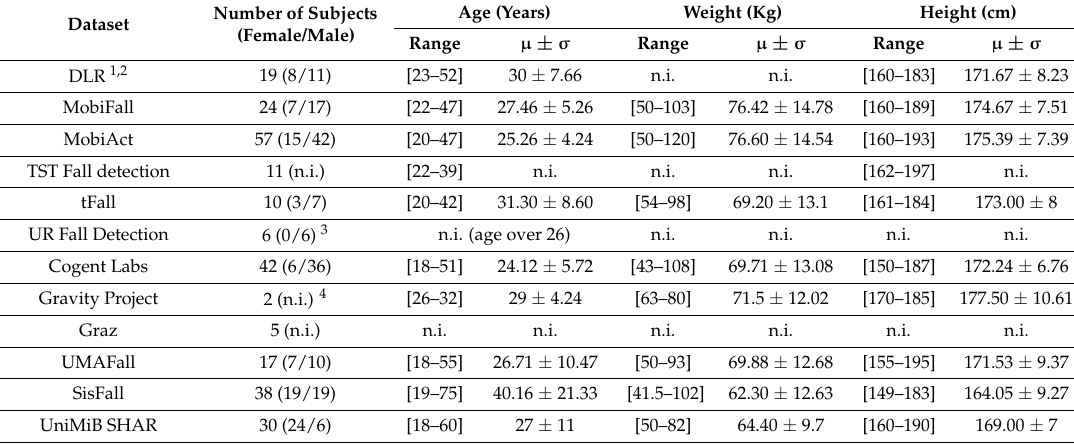
Table 3. Characteristics of the experimental